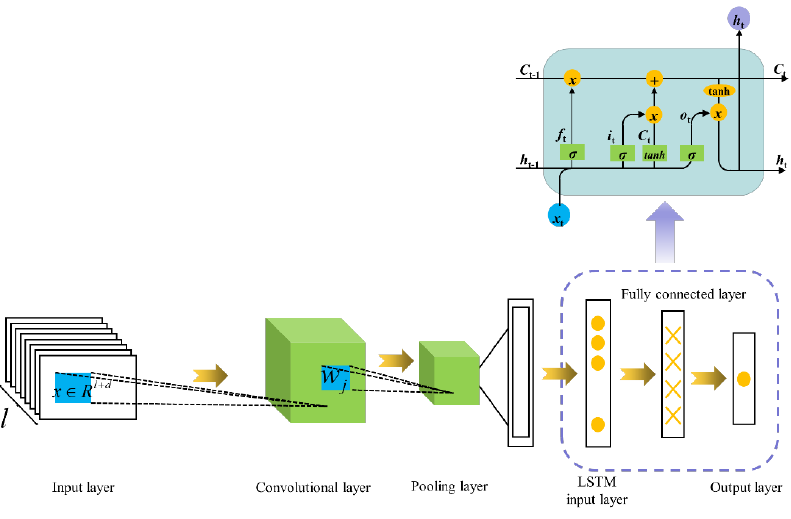
Figure 6. CNN-LSTM algorithm flow chart.